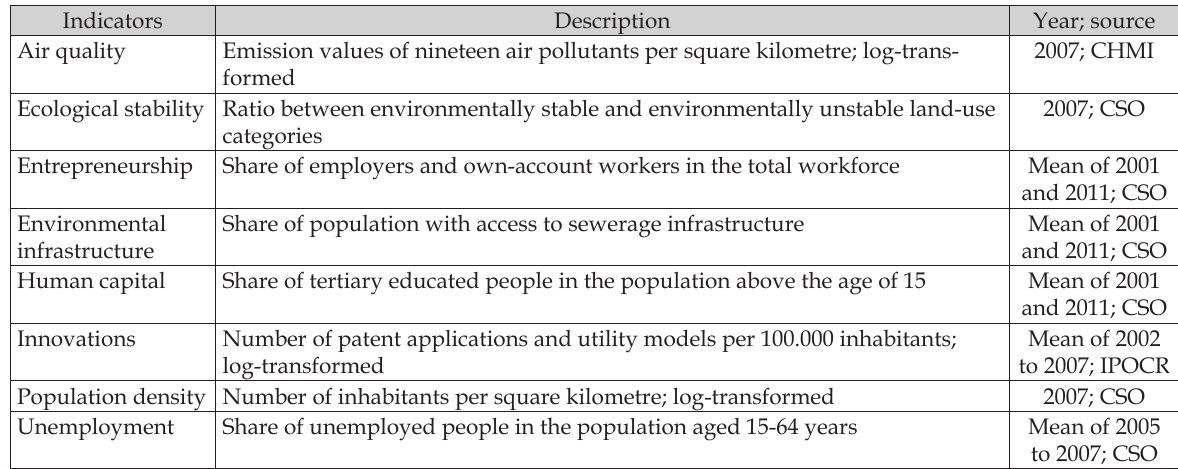
Table 1. The socio-economic disadvantages of micro-regions –